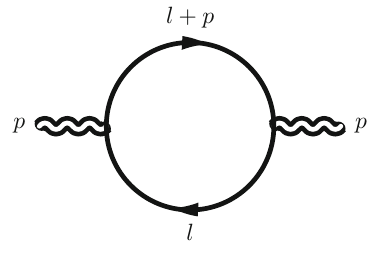
Fig. 2 The only 1 loop contribution to the two-point correlation func- tion being a massless tadpole contribution. In this case the per- turbative expansion generates three diagrams of box type, represented by the Green function with 4 EMT insertions on the right hand side of (22), plus triangle, bubble and tad- pole diagrams generated by the contact terms and graphically represented in Figs. 4 and